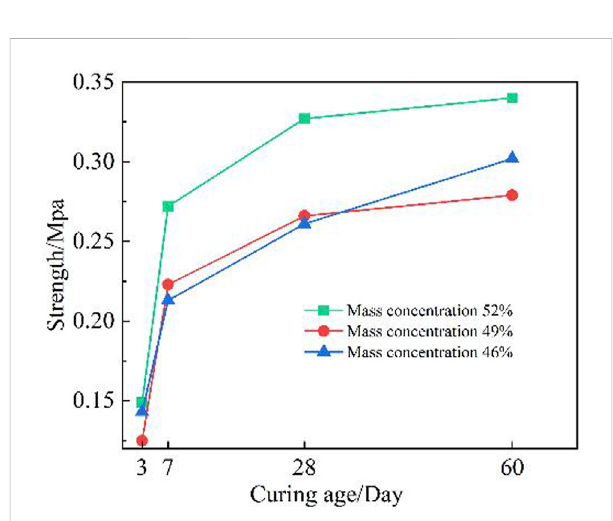
FIGURE 5 Variation of the strength of back fi ll materials with age for ash- tailings ratio